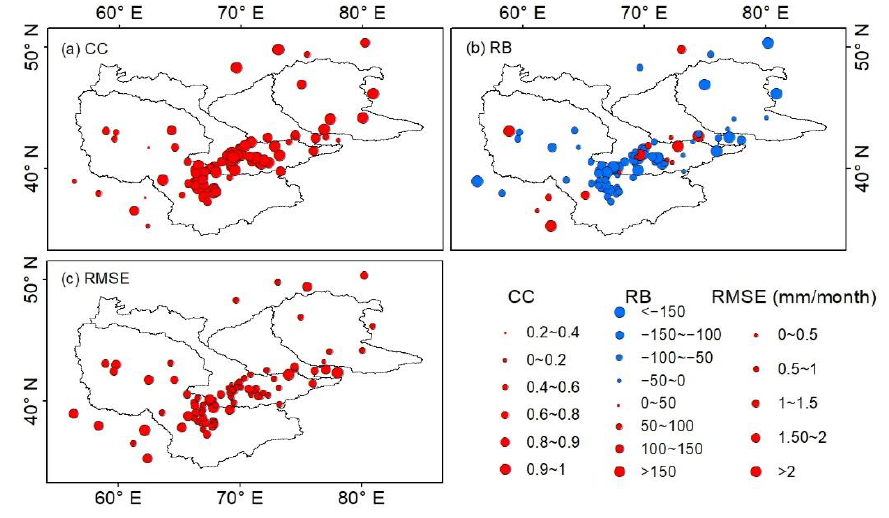
Figure 7. The SPI3 spatial patterns of CC, RB, and RMSE between sites and